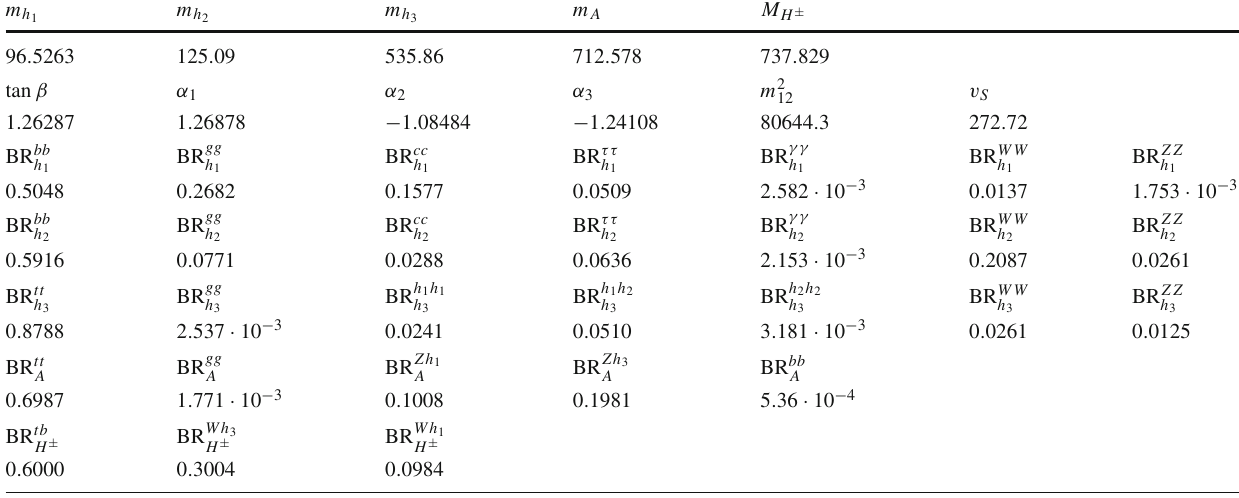
Fig. 5 Type IV: the signal strengths μ CMS and μ LEP for each scan point respecting the experimental and theoretical constrains. The 1 σ -region of both excesses is shown by the red ellipse. The colors show the mass of the charged Higgs. The magenta star indicates the best-fit point. The lowest (highest) value of M H ± inside the 1 σ ellipse is 650 . 01 ( 931 . 85 )